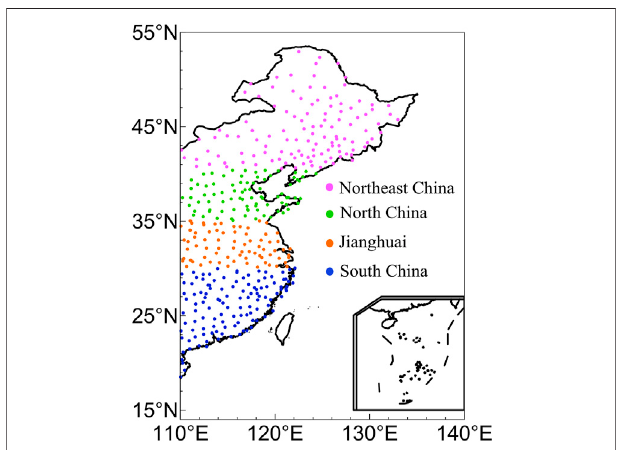
FIGURE 1 | Locations of the 397 weather stations in Eastern China. Each sub-region is indicated by different colors.